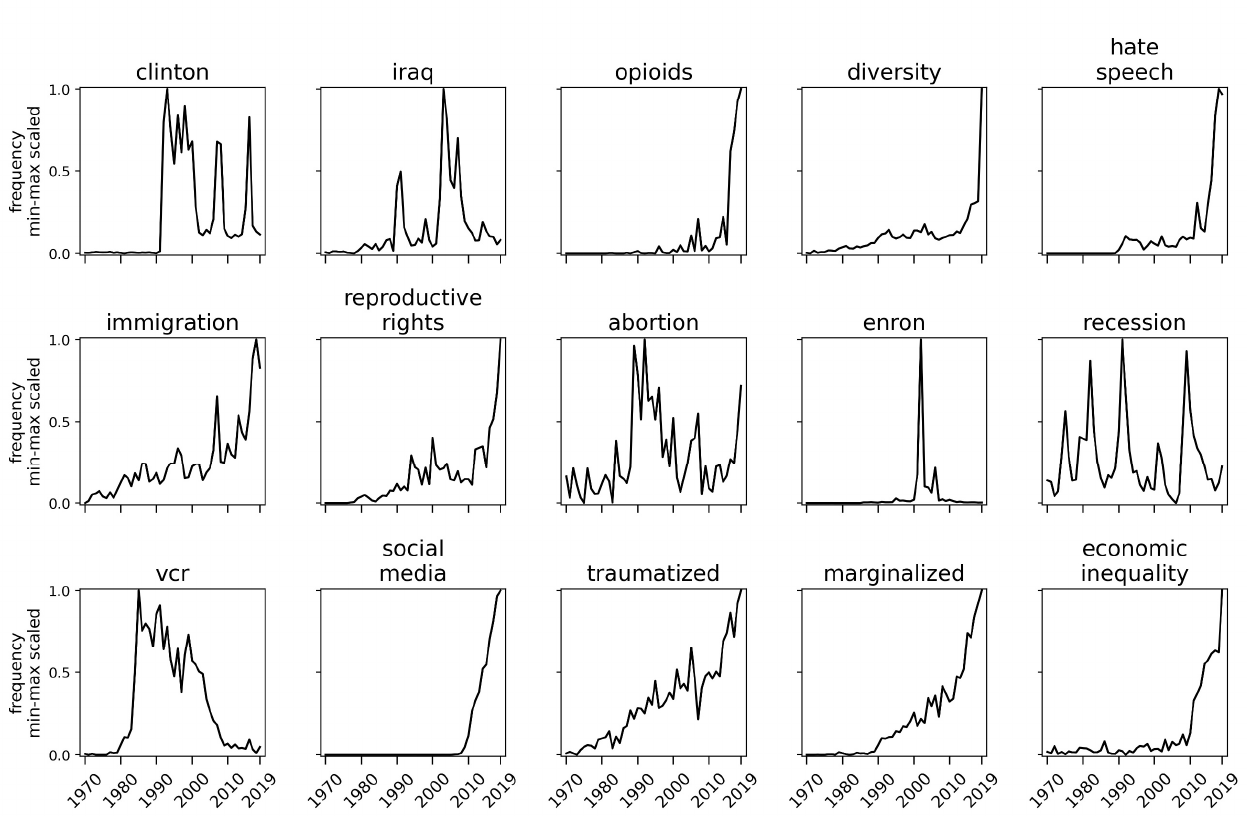
Figure 1. Min-max scaled yearly frequencies of word usage in New York Times articles.